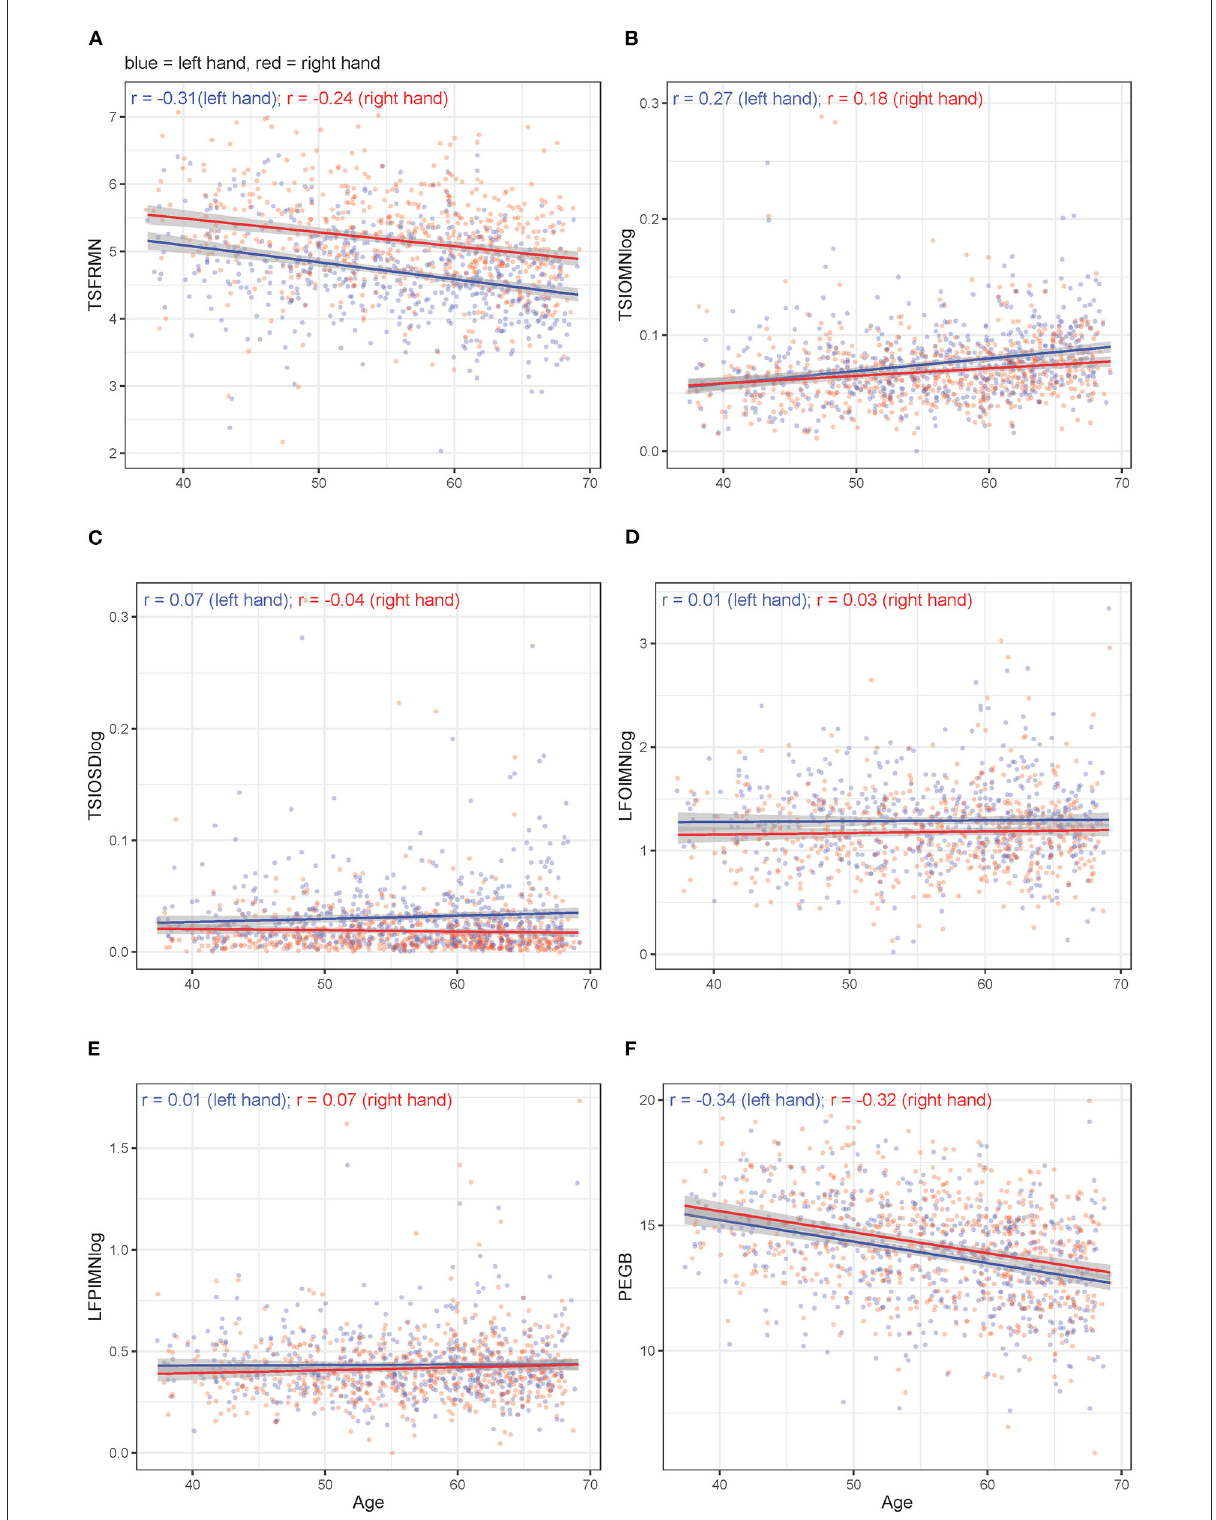
FIGURE3 (A–F) Unadjusted, bivariate associations between age and the motor outcomes in right-handed participants for left and right hands